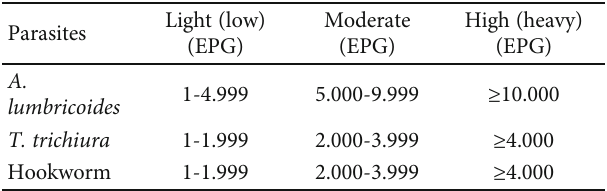
Figure 1: Map of the study area [6]. Table 1: Thresholds for classi fi cation of STHs according to degrees of infection.